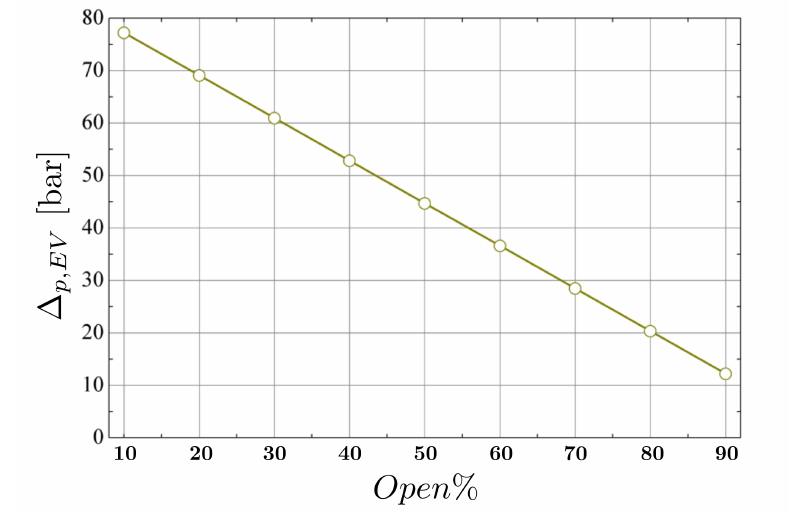
Figure A7. Static pressure drop over EV vs EV orifice